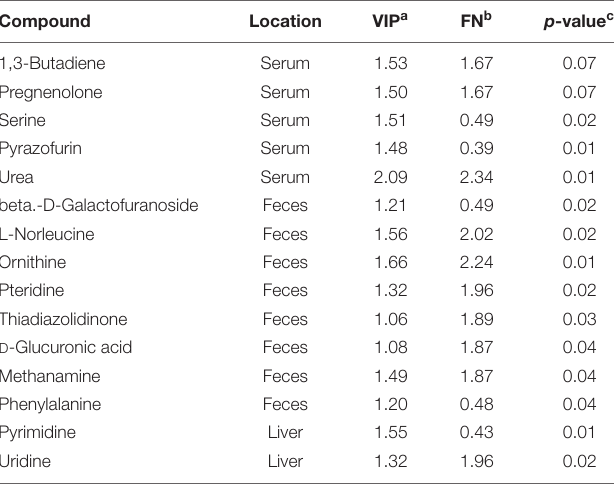
TABLE 1 | The special metabolites detected in BS group of ALI compared with control group. Compound Location VIP a FN